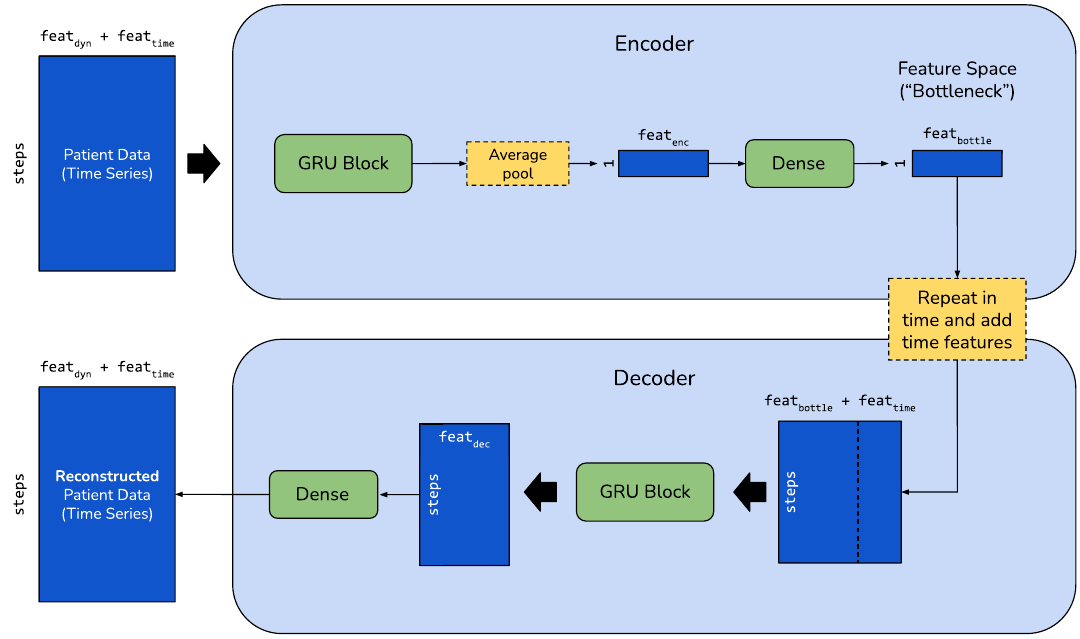
Figure 7. Neural network model. The model consists of an encoder and a decoder part, but these parts are trained jointly. Neural network layers are shown using green boxes with round corners; blue boxes represent tensors, and vector operations like concatenation are shown as yellow boxes with dashed lines. The GRU block is part of the encoder and the decoder and consists of a bidirectional GRU layer, whose outputs are summed for each time step. In the encoder, the resulting features are average pooled over time and then processed using a dense layer, resulting in the encoder’s output: the bottleneck. The decoder repeats the low-dimensional representation in time and concatenates it with the original input’s time features. The same GRU block architecture as for the encoder is used to calculate the temporal dynamics of the time series. Weights are not shared between the two GRU blocks in the model. As a final step, a dense layer is applied to each time step to reconstruct the original features. The model is trained to predict its original